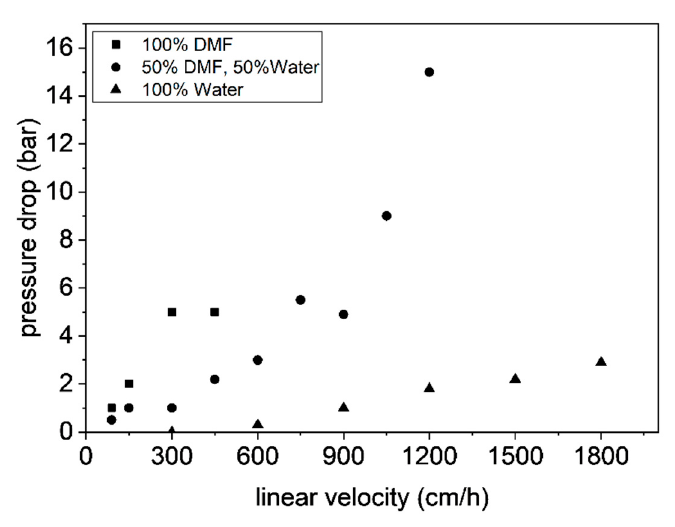
Figure 9. Impact of solvent used during the click reaction on pressure drop increase during aqueous phase chromatography at different linear velocities.